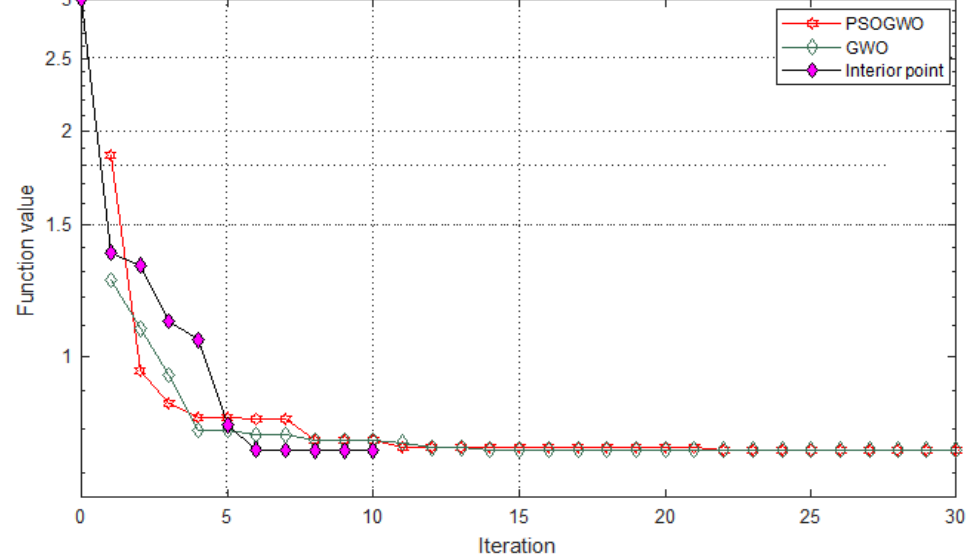
Figure 7. Convergence graph of algorithms for optimizing relay TMS value.